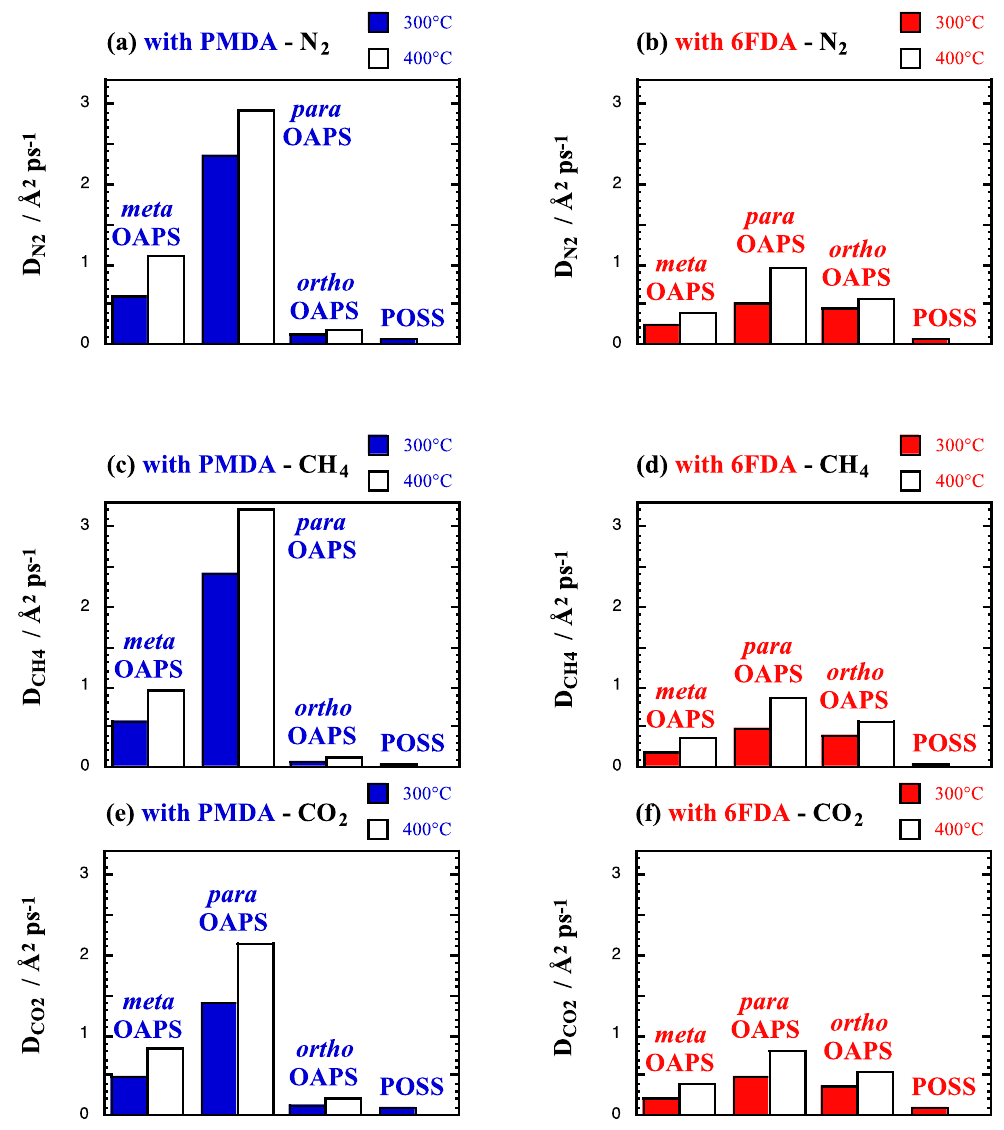
Figure 6. Single-gas diffusion coefficients D gas at 300 ◦ C and 400 ◦ C in the PMDA and 6FDA polyOAPS/POSS-imides for ( a , b ) N 2 , ( c , d ) CH 4 and ( e , f ) CO 2 feeds at 60 bar. The maximum standard error is 0.1 Å 2 ps −1 .